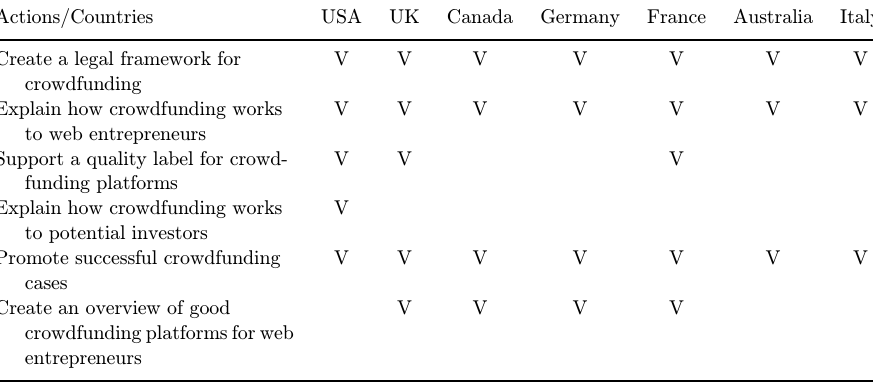
Table 3. View of various countries' actions to deal with crowdfunding. 31